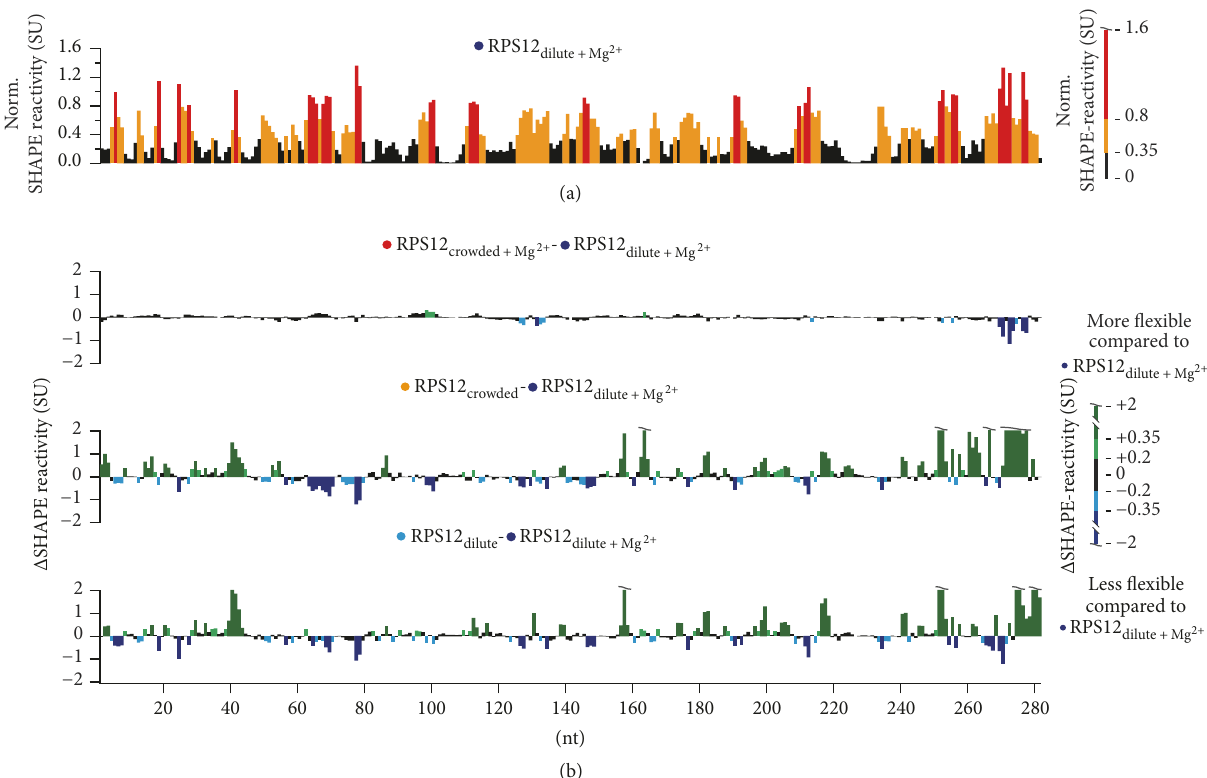
Figure 2: (a) Normalized SHAPE-reactivity profile of the RPS12 pre-mRNA in dilute solvent conditions. Black: low ( < 0.35 SU); orange: medium (0.35 ≤ SU < 0.8); red: high ( ≥ 0.8) normalized SHAPE reactivities. SU: SHAPE-unit. nt: nucleotide(s). (b) Difference ( Δ ) SHAPE- reactivity profiles of the RPS12 transcript at crowded and/or Mg 2+ -free solvent conditions. Green: nt-positions with increased SHAPE reactivities (dark green: 0.35 ≤ SU ≤ 2; light green: 0.2 ≤ SU < 0.35). Blue: nt-positions with decreased SHAPE reactivities (light blue: − 0.2 ≥